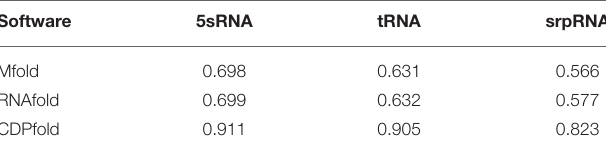
TABLE 4 | Comparison of three types of RNA based on their prediction